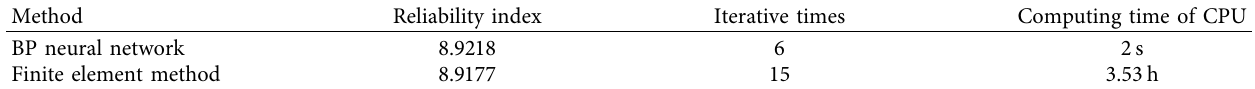
Table 3: Comparison results of reliability index of vehicle-bridge